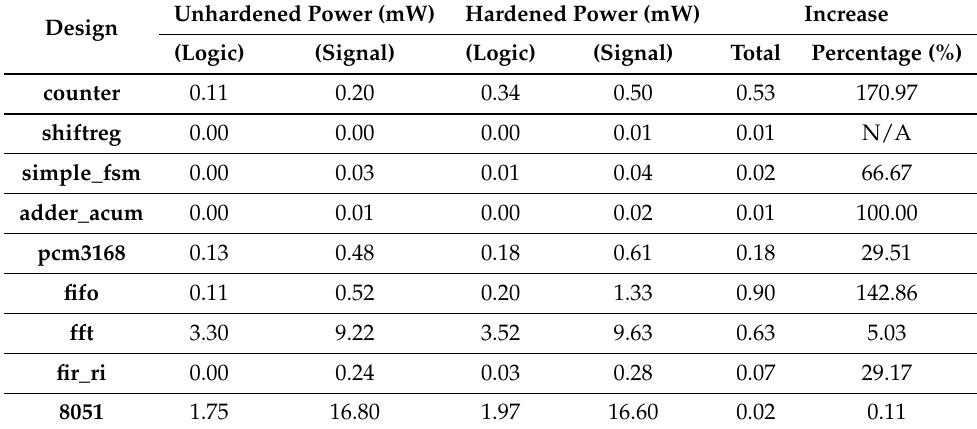
Table 10. Power consumption estimation of hardened and unhardened versions of the designs under test, synthesized with